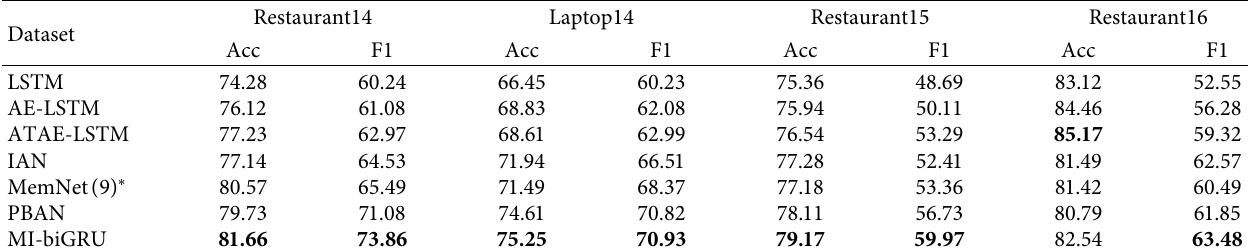
Table 4: Performance of different models on sentiment analysis datasets.